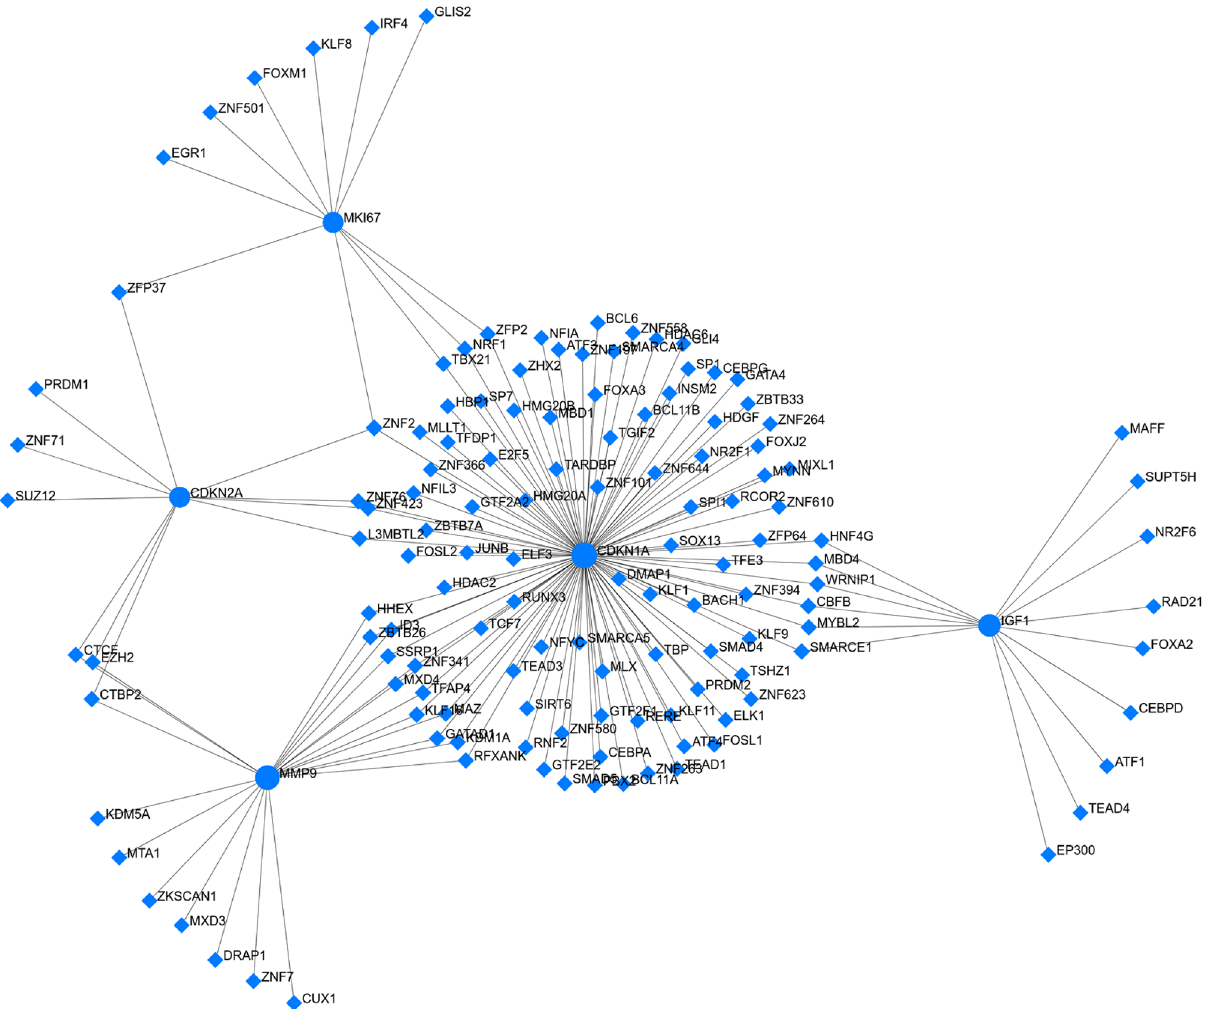
Figure 5. TF-gene biomarker regulatory network generated by NetworkAnalyst (version 3.0; http:// www. netwo rkana lyst. ca). The network revealed 164 interaction pairs among 5 seed genes and 139 transcription factors (TFs). Blue circle stands for the seed gene and blue diamond stands for the transcription